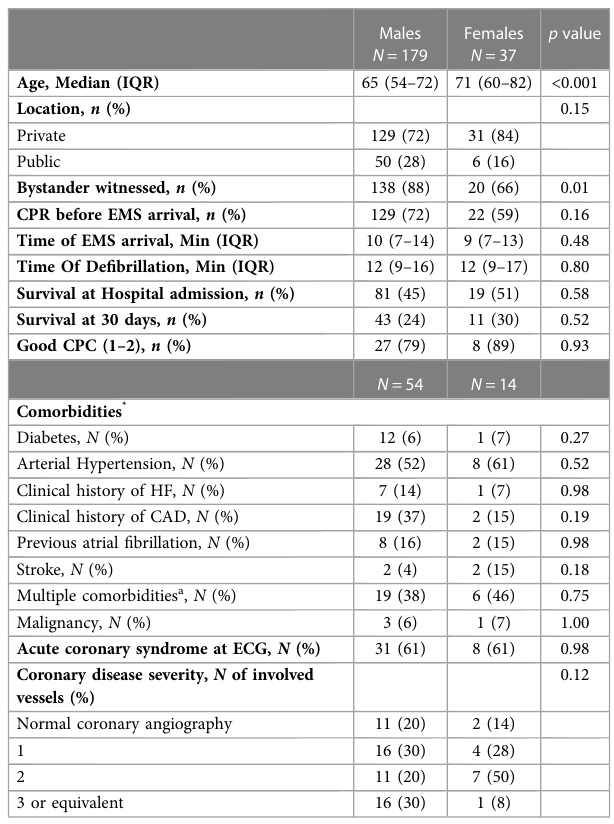
TABLE 3 Sex related differences in OHCA presenting with refractory